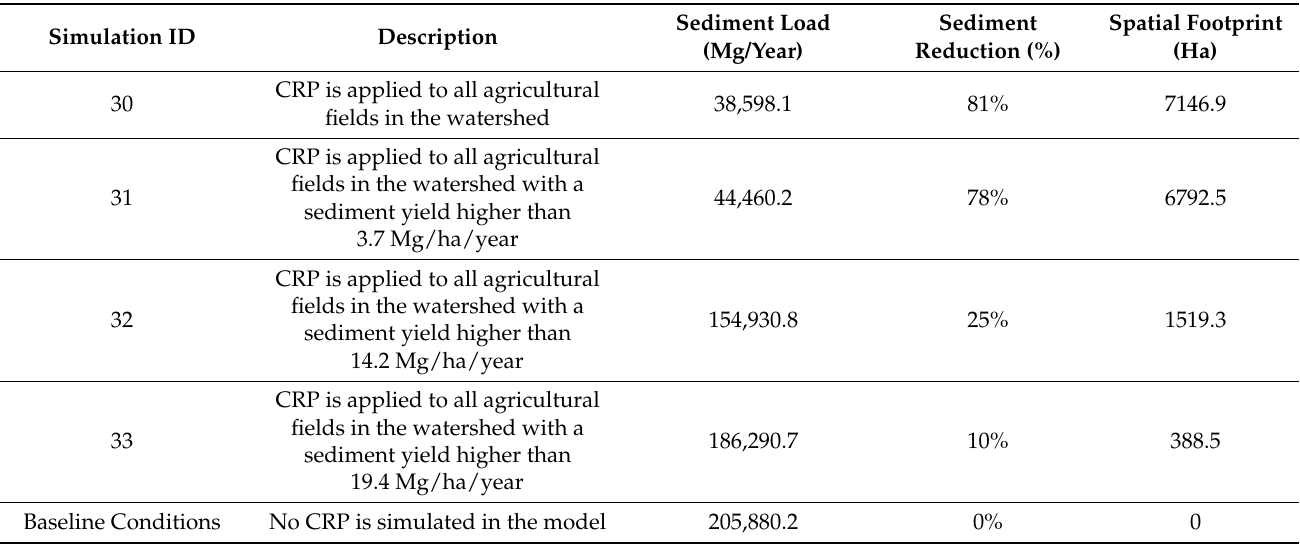
Table 7. CRP scenarios